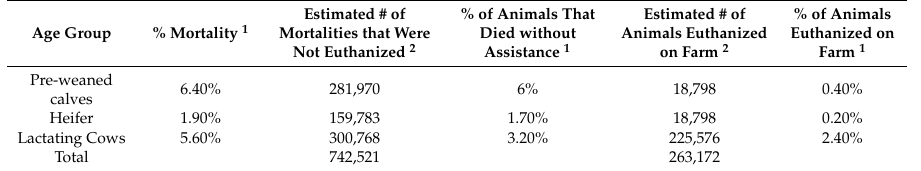
Table 2. Estimates of the number of dairy cattle by age group that die annually on dairy farms based on self-reported estimates of mortality and euthanasia rates reported in the 2014 NAHMS Health and Management Practices on U.S. Dairy Operations report [4]. Number of animals a ff ected based on NAHMS estimates applied to the total number lactating cows, heifers and pre-weaned calves [18]. Estimated # of % of Animals That Estimated # of % of Animals Age Group % Mortality 1 Mortalities that Were Died without AnimalsEuthanized Euthanized on Not Euthanized 2 Assistance 1 on Farm 2 Farm 1 Pre-weaned calves